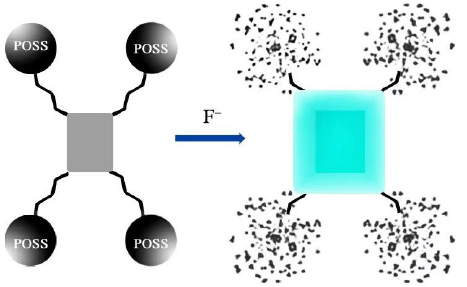
Figure 21. Schematic illustration of the sensing mechanism of TPE-POSS toward F¯ [102].